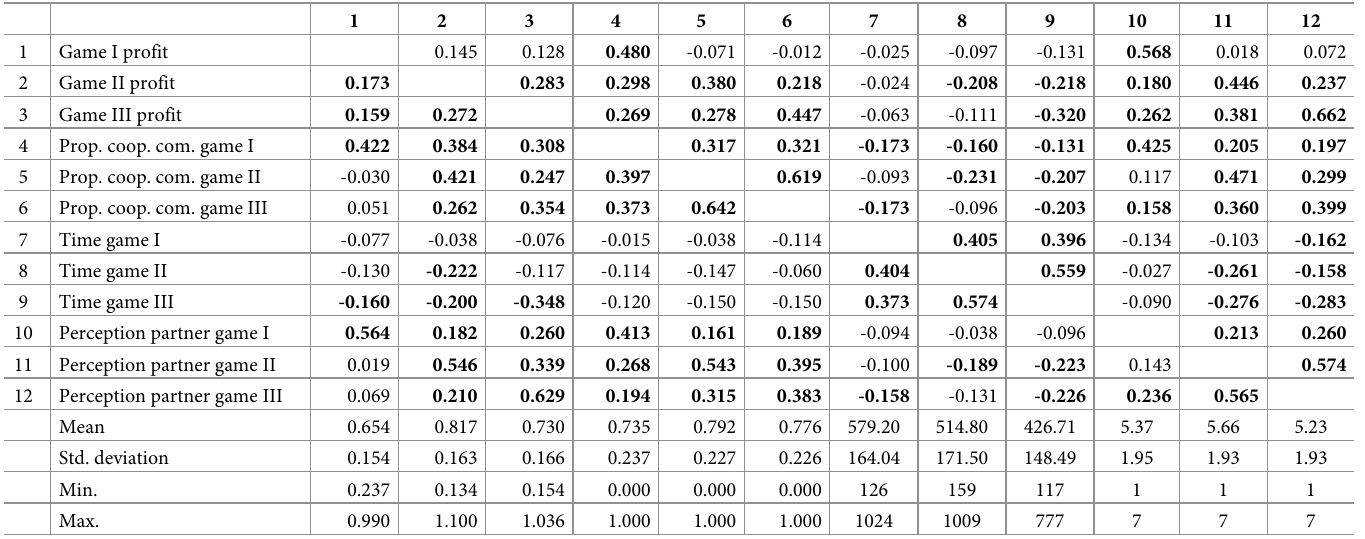
Table 2. Descriptive statistics and